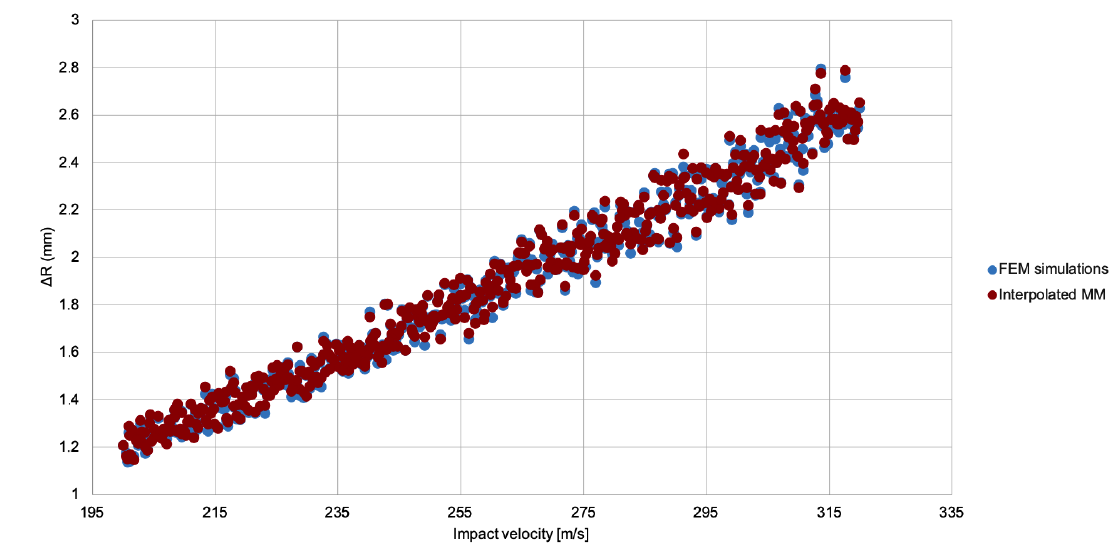
Figure 11. Comparison of meta-models interpolated results and FEM simulation results, considering ∆ R for the Zerilli–Armstrong model.